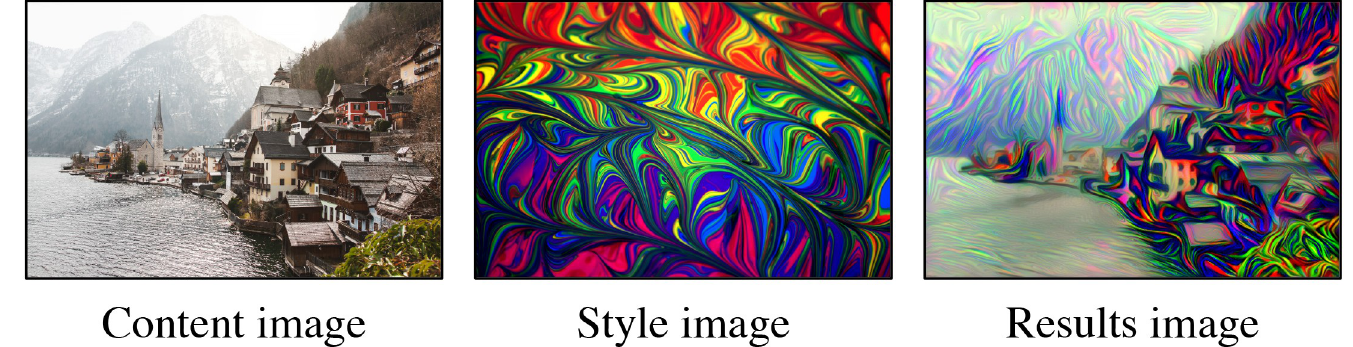
Fig 2. An example of NST. Features of the style image are blended into the structure of the content image in the results image.